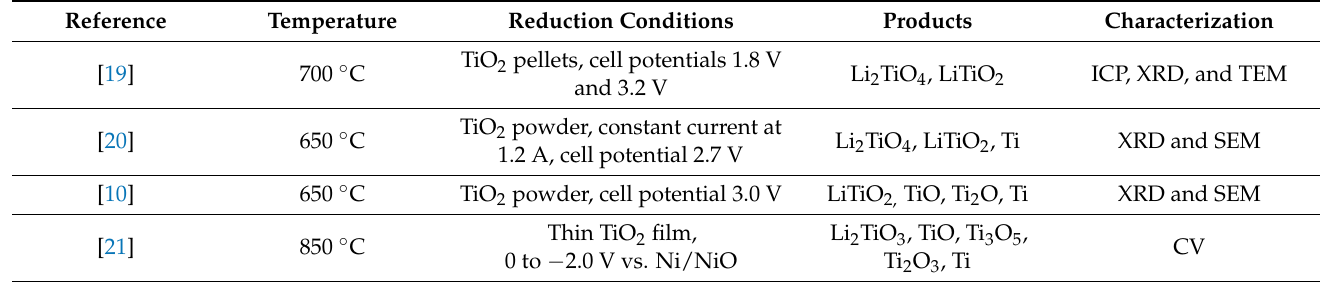
Table 1. Electrolytic reduction products for TiO 2 in LiCl